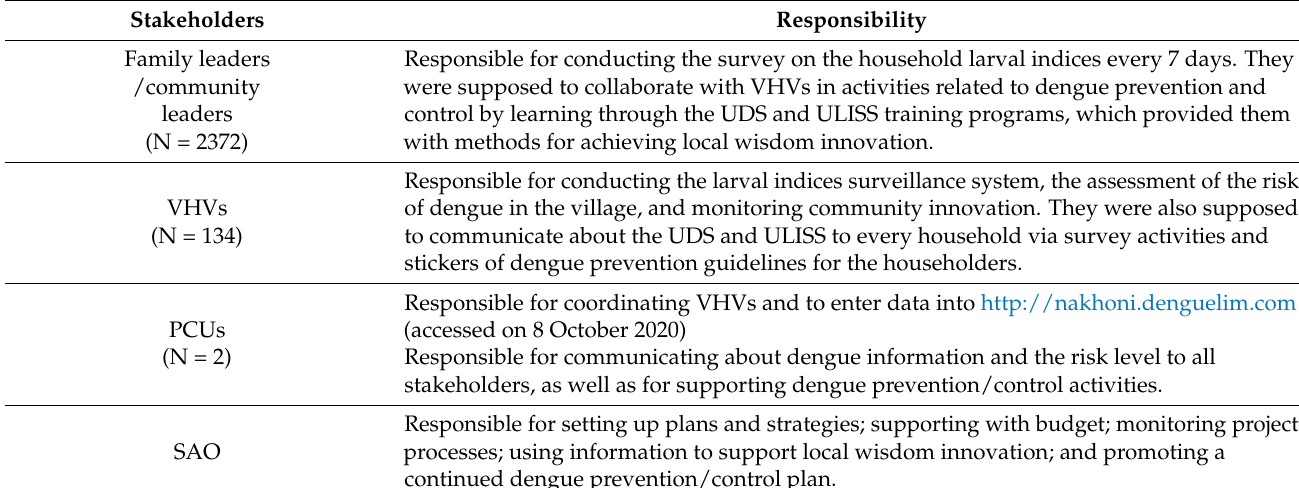
Table 2. Stakeholders of the Keawsan SAO dengue model and their responsibilities for the imple- mentation